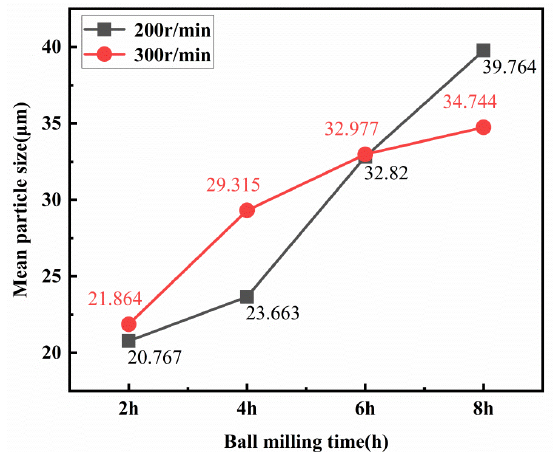
Figure 3. Mean particle size of 0.5 wt.% GNP/Al powder vs. ball milling time.